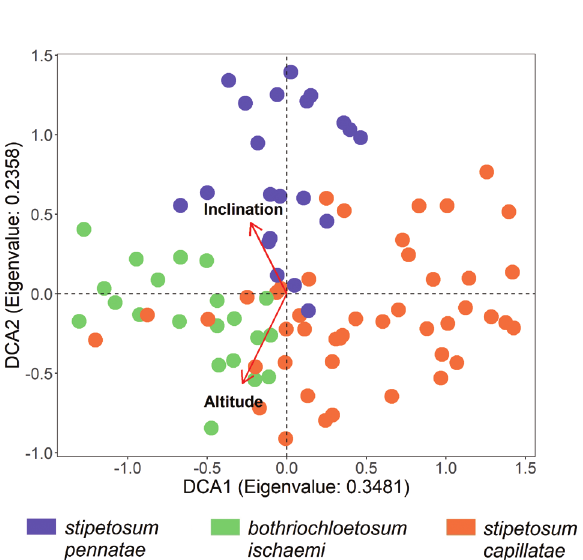
Figure 5. Ordination (DCA) of the Festuco-Caricetum su- pinae . Three subassociations are shown, characterized by the dominant species Stipa capillata , Bothriochloa ischaemum , and Stipa pennata agg. Transitions between the subassociations are